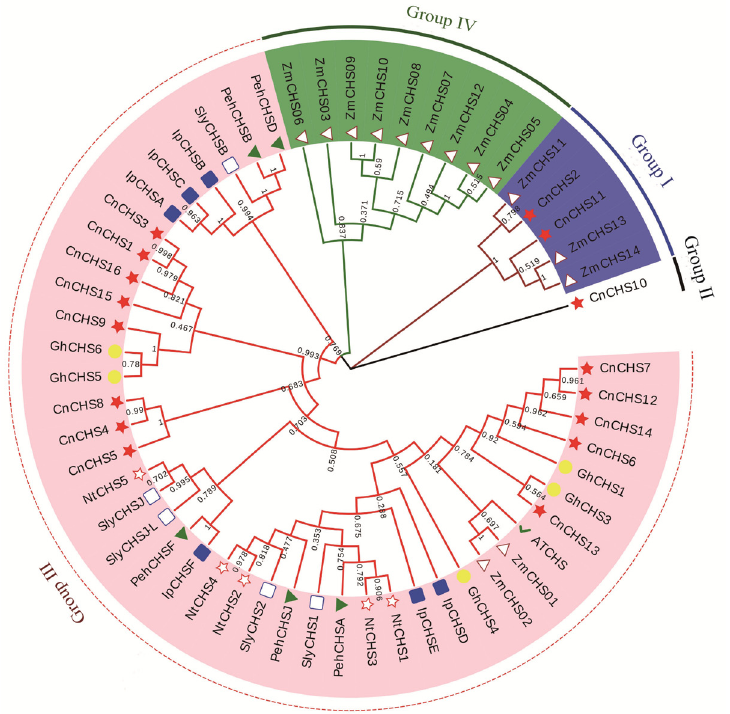
Figure 2. Phylogeny of selected CHS genes based on their neighbor-joining distance. AtCHS = Ara- bidopsis chalcone synthase, GhCHS = G. hybrid chalcone synthase, PehCHS = petunia chalcone syn- thase , IpCHS = common morning glory chalcone synthase, SlyCHS = tomato chalcone synthase, NtCHS = tobacco chalcone synthase, ZmCHS = maize chalcone